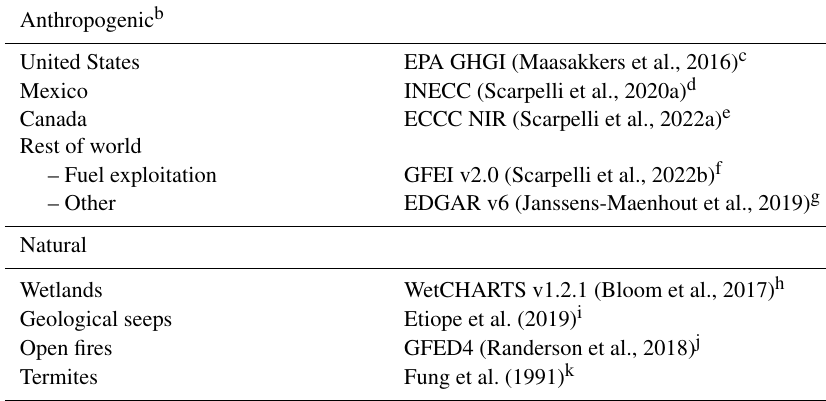
Table 1. Bottom-up methane emission inventories used as default prior estimates in IMI 1.0 a